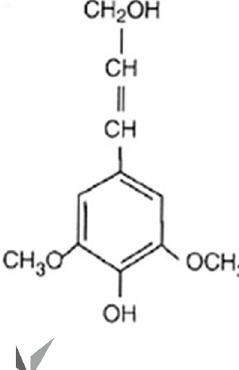
Fig. 3 Molecular structure of one of the dominant building block of